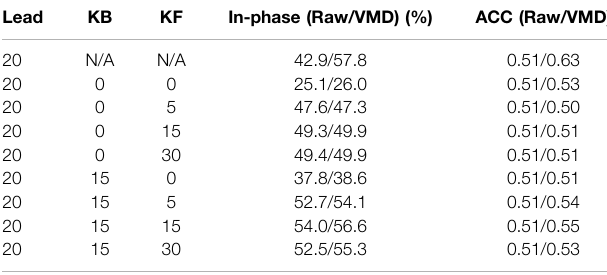
The fi rst line is for the result in the regular real-time forecast and intraseasonal fi ltered historical forecast. The latter and the best improved results are marked by red.